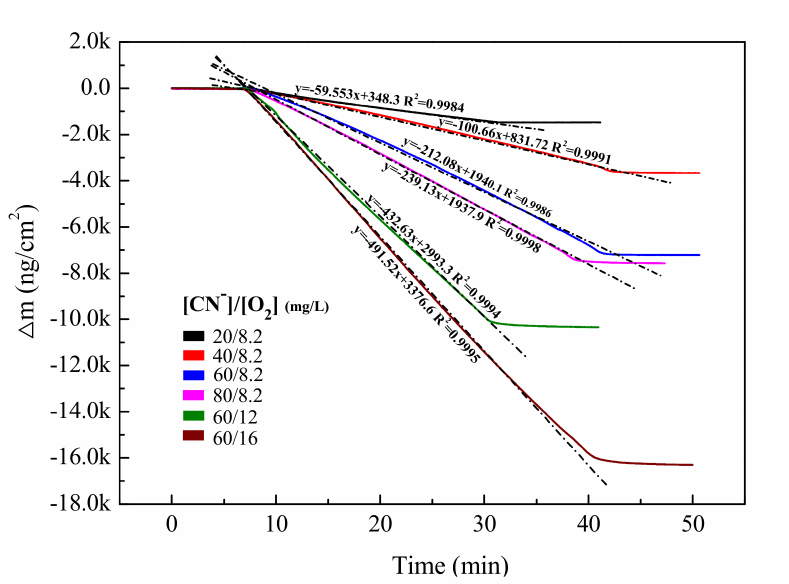
Figure 8. The Sauerbrey equation calculated a mass shift in ∆ m and was fitted to be linear at different [CN − ]/[O 2 ] in the injection